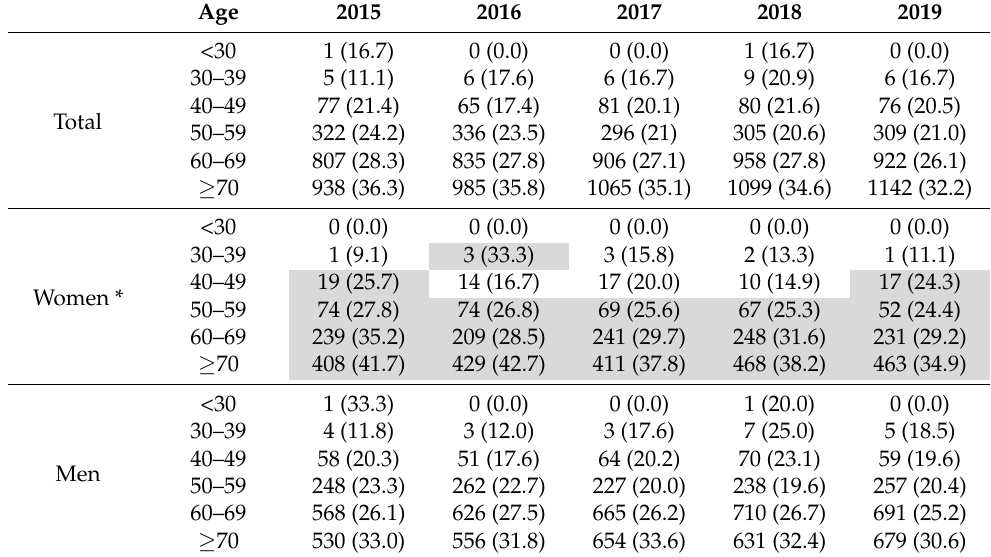
Table 4. Major lower extremity amputations by years, according to sex and age (absolute number